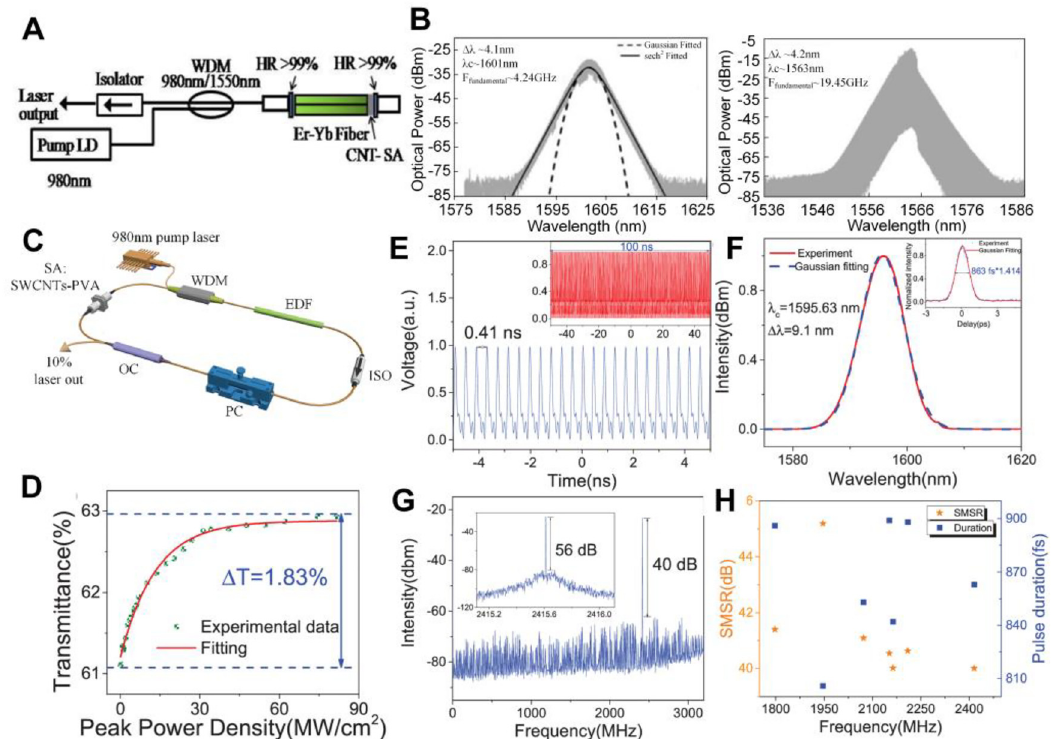
Figure 7: High repetitionrate CNT-SAmode-lockedfiberlasers: (A) CNT-SAbased highrepetitionrate laser usingshort Fabry – Pérotcavity;(B) OpticalspectrumofthelaserusingshortFabry – Pérotcavityatrepetitionratesof ∼ 4.24and ∼ 19.45GHzwithcavitylengthof 25,10,and5mm, respectively, Martinez et al. [56]. © Optical Society of America 2011. (C) SWCNT-SA based Harmonic mode-locking laser; (D) nonlinear transmissionof theCNT;(E)oscilloscoperesults;(F)Opticalspectrum; (G)Radiofrequencyspectrumshowingtherepetitionrateof 2.415GHz; (H) The variations of SMSR and pulse duration when pulses frequency ranges from 1.8 to 2.415 GHz, Huang et al. [58]. © IEEE